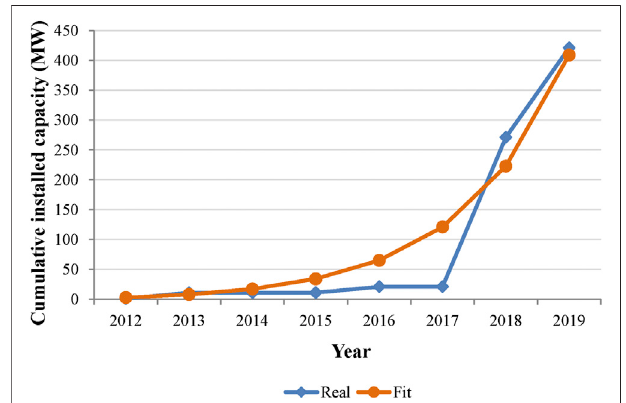
FIGURE 4 | Fitted model of cumulative installed capacity.